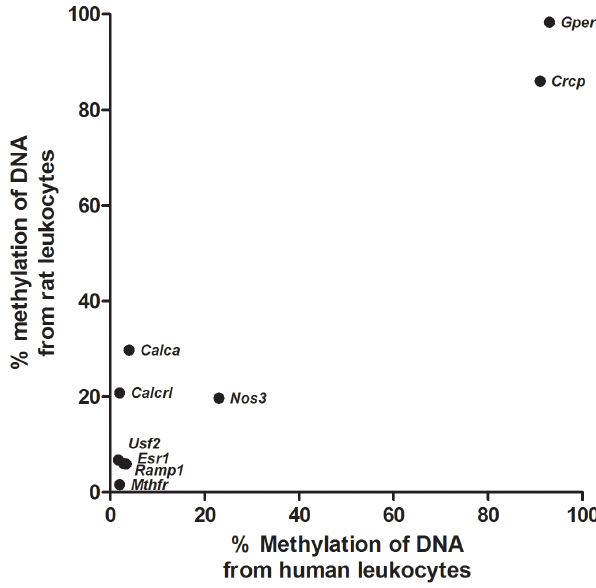
Figure 3. Rat leukocyte DNA methylation compared to human leukocyte DNA methylation. The methylation of DNA from rat leukocytes is compared to methylation of DNA from human leukocytes for different migraine-related genes. Our genes of interest that are high methylated in rat leukocytes, are also high methylated in human leukocytes and the genes that are low methylated in rat leukocytes are also low methylated in human leukocytes.